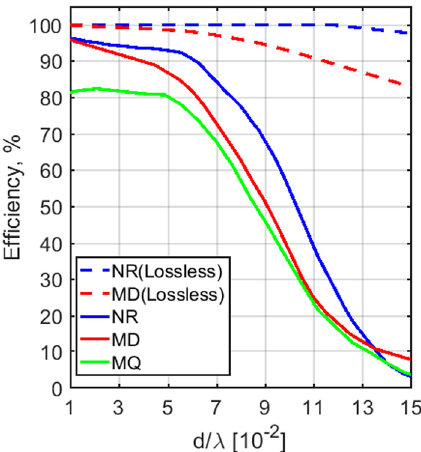
Figure 6: Results of numerical simulations of the WPT system: comparison of WPT efficiencies (calculated by Eq. (1)) of proposed system operating at NR, MD, and MQ modes as functions of the power transfer distance, which is normalized separately by their operational wavelengths 𝜆